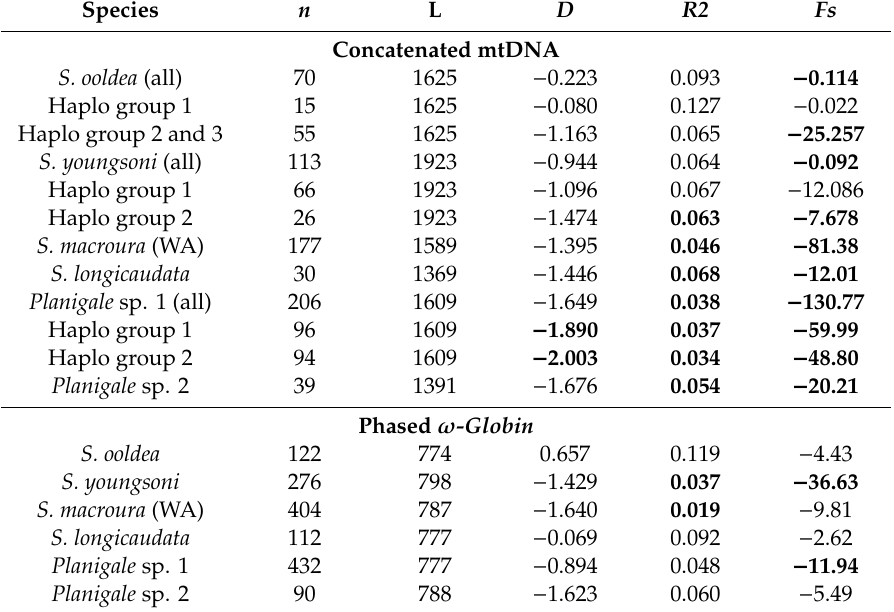
Table 4. Expansion statistics for the concatenated mtDNA ( CR + cytb ) and the phased nuclear ( ω -globin ) gene alignments of the six species in this study. Some species were grouped according to mtDNA haplo groups from the network analysis that also successfully converged in the skyline analysis. Number of samples ( n ), sequence length in base pairs excluding alignment gaps (L), Tajima’s D ( D ), Ramos-Onsins and Rozas R2 ( R2 ), Fu’s Fs ( Fs ). Significant test scores are shown in bold font ( p values of < 0.01 considered significant for Fs